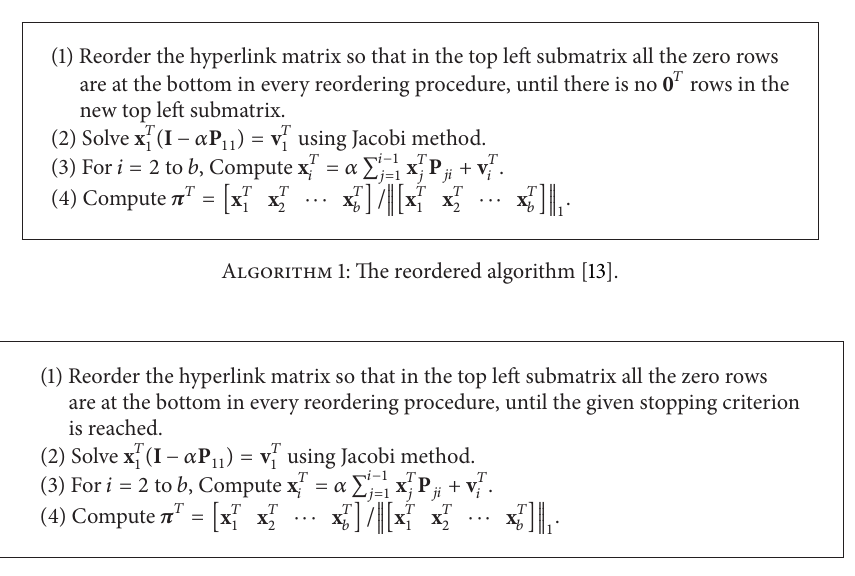
Algorithm 2: The adaptive reordered